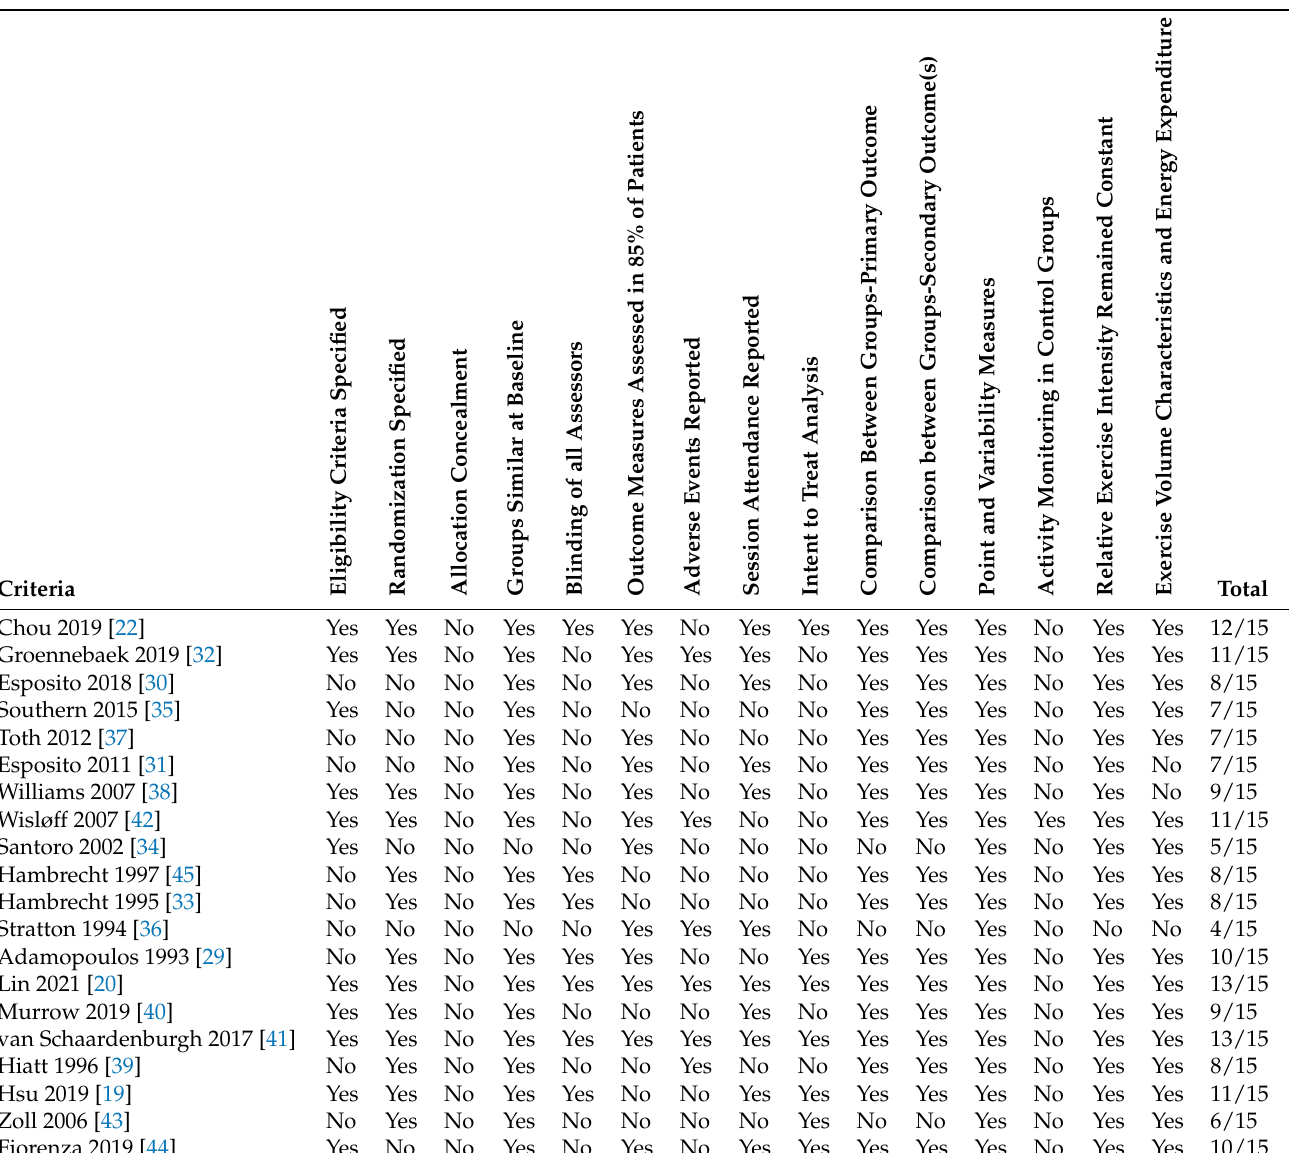
Table 2. Quality assessment of the studies according to the TESTEX scale ( n =